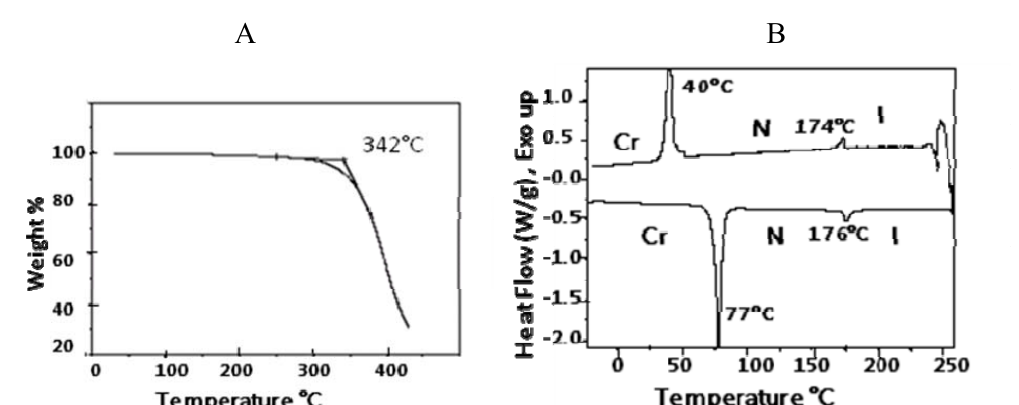
Figure 4. Thermogravemetric analysis and DSC graph of benzoic acid, 4-(4-pentenyloxy)-, 2-chloro-1,4-phenylene ester ( 4